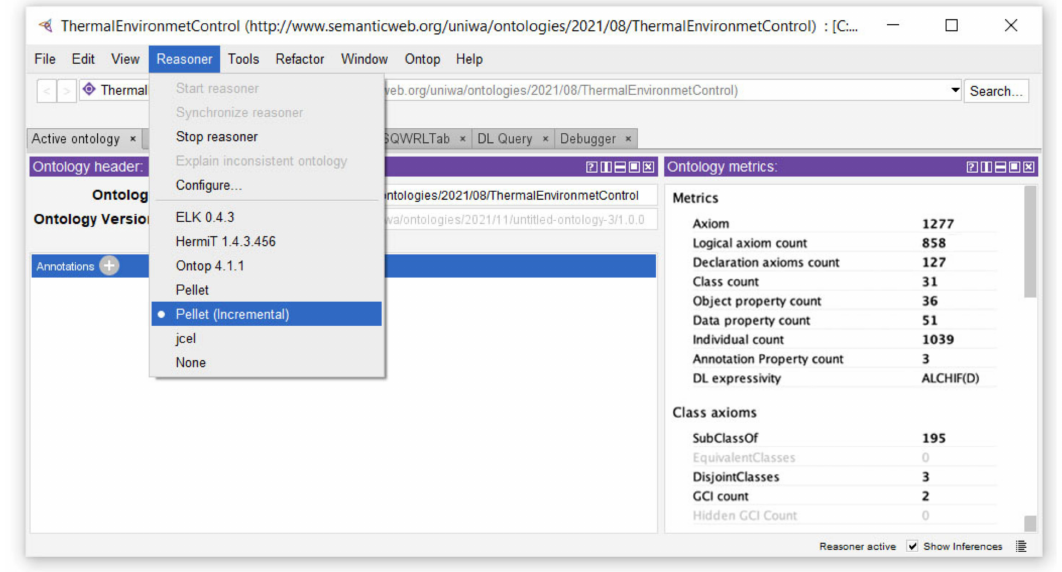
Figure 17. Verification of modeling structure